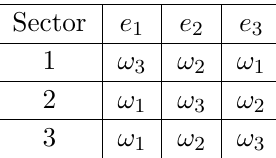
Table 4 . Squashing parameters and equivariant parameters in each